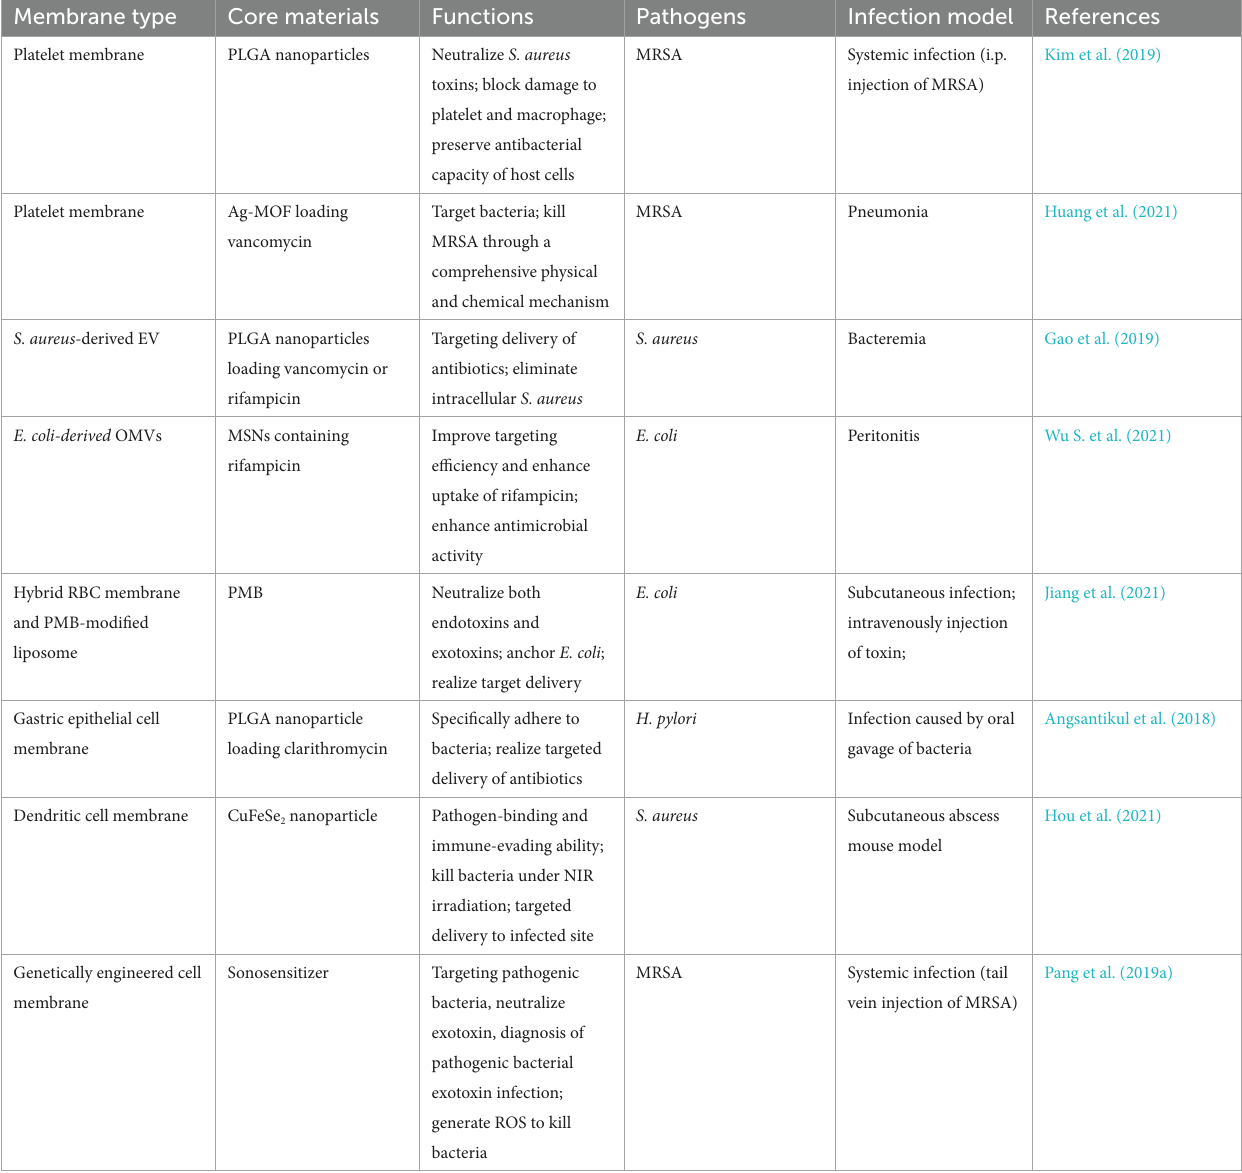
TABLE 3 Representative cell membrane coated nanoparticles for therapy of bacterial infection, in which cell membranes are derived from platelet, bacteria and other